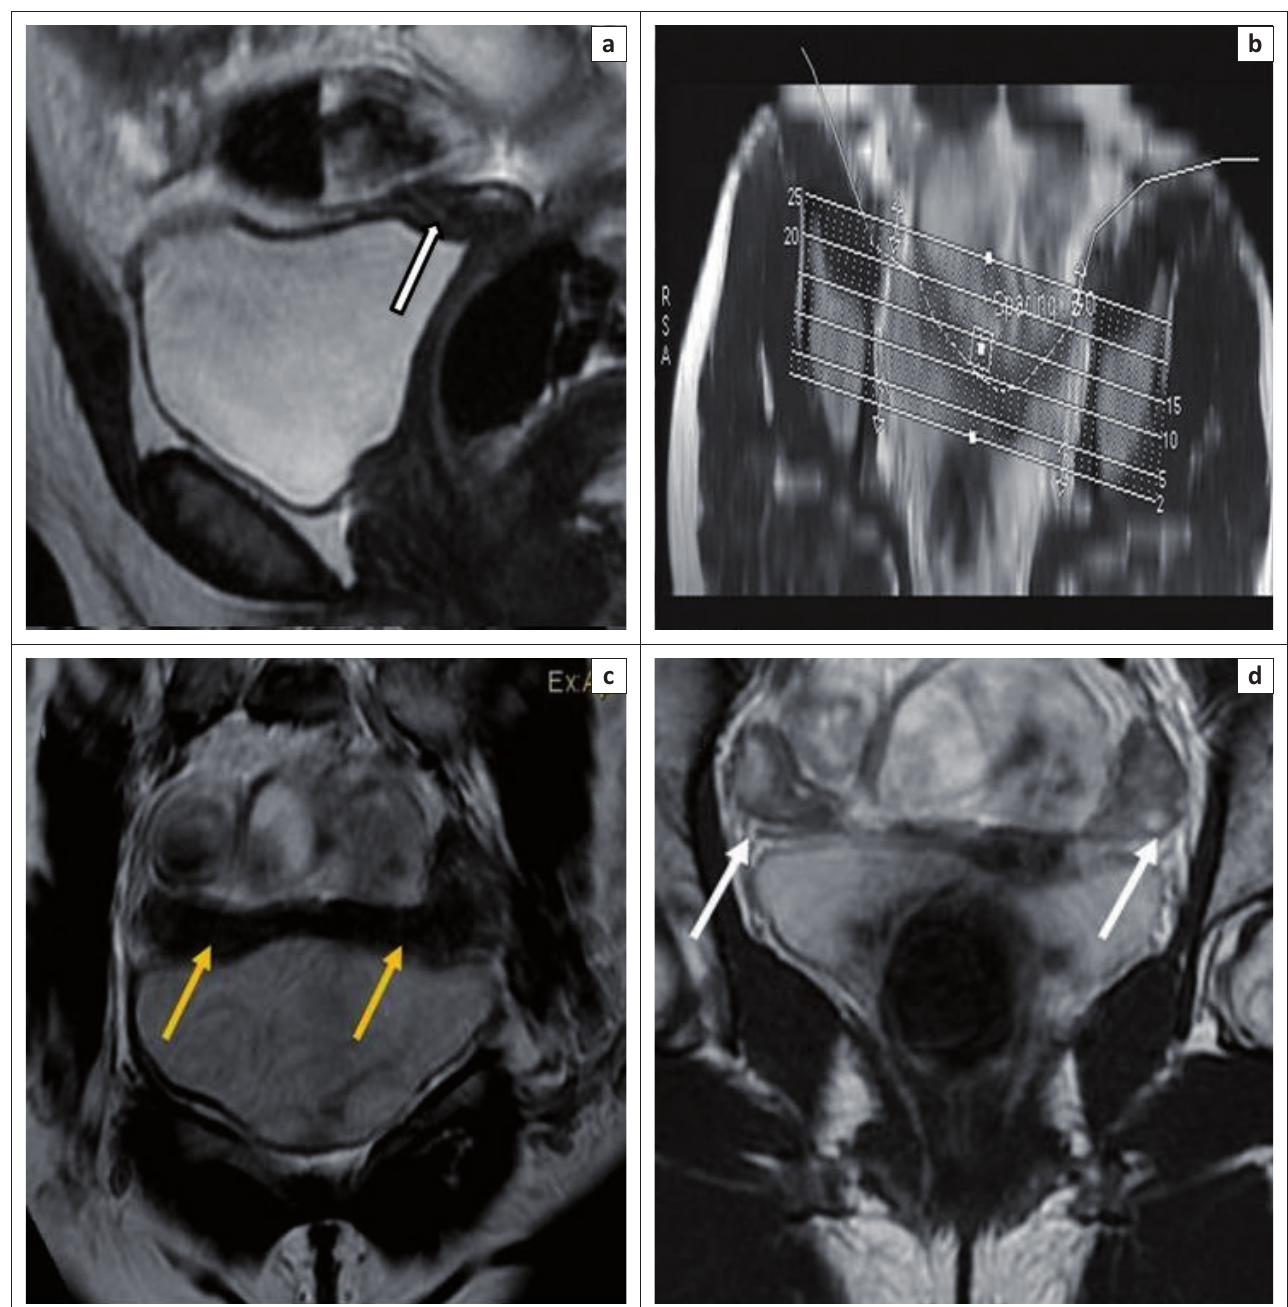
FIGURE 2: (a) Sagittal T2 sequence demonstrates a rudimentary uterus (white arrow). (b) Planning of the T2 CUBE curved maximum intensity projection (MIP). (c) T2 cube curved MIP demonstrates a bicornuate rudimentary uterus with an intercornual distance of more than 4 cm and widely separated (yellow arrows). (d) Coronal T2 sequence shows both ovaries (white arrows).